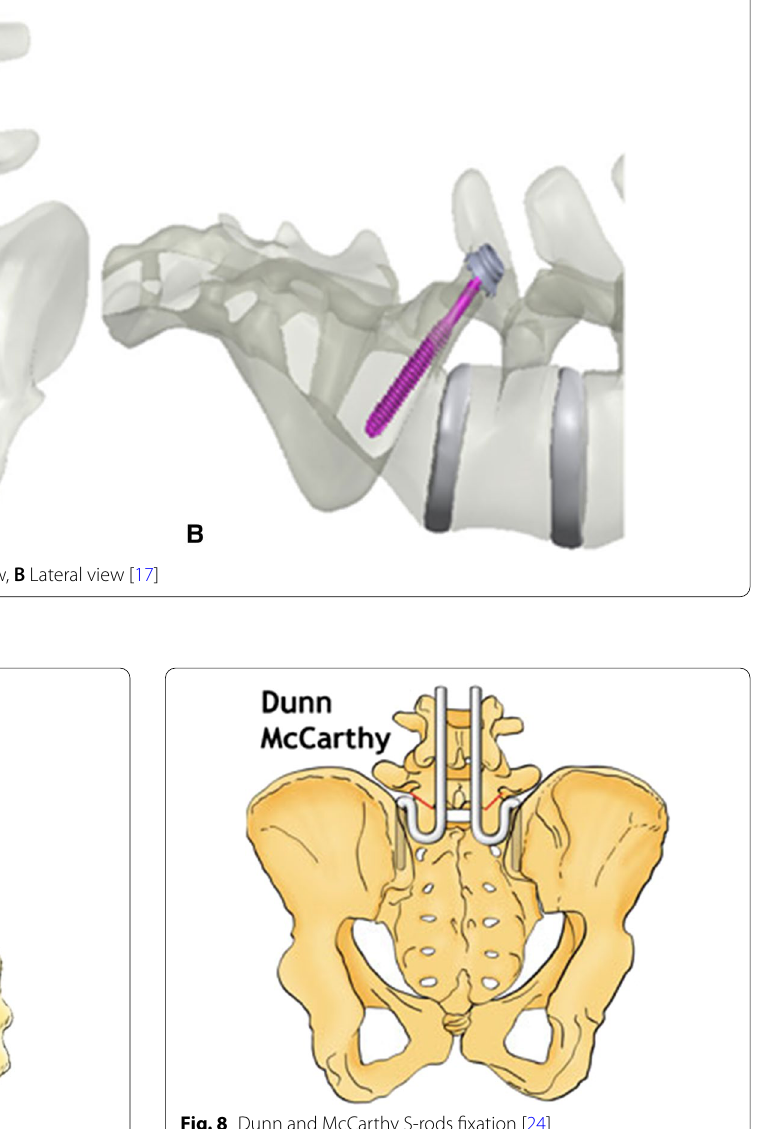
Fig. 8 Dunn and McCarthy S-rods fixation